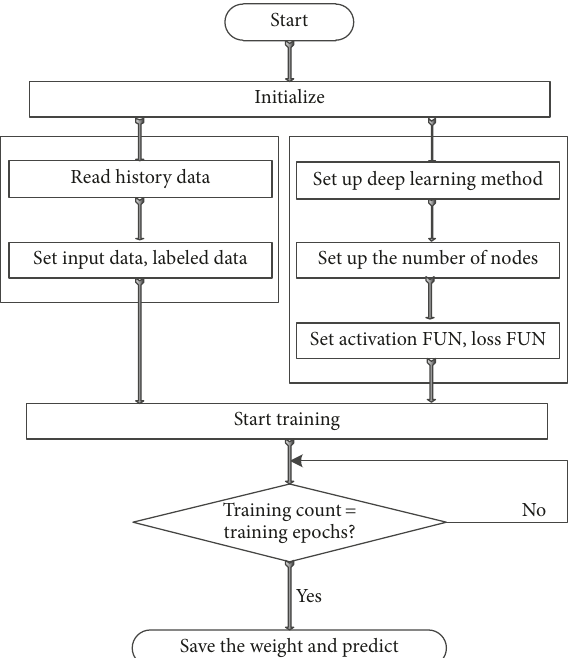
Figure 2: Prediction process of daily passenger flow of rail transit station.